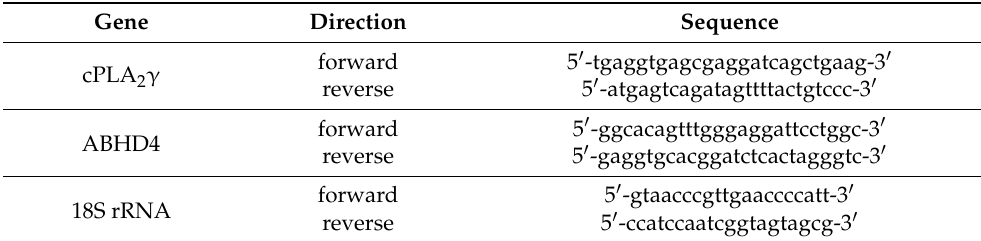
Table 2. Primers used for reverse transcription-PCR. Gene Direction Sequence cPLA 2